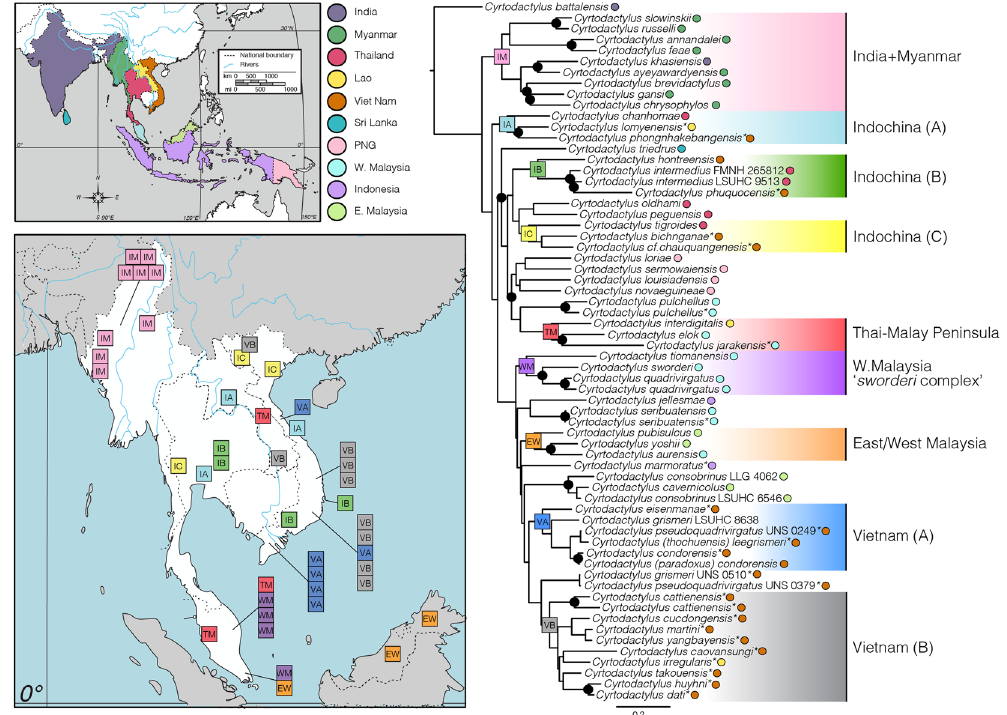
Figure 2. ‘Standardized ND2 ’ Maximum likelihood genealogy of ND2 including only taxa for which COI sequence data also exist. Circles at nodes indicate clade congruence between ND2 and COI loci, with BSS values of ≥ 70: blue indicate species groups, black interspecific sampling. Asterisks indicate new ND2 sequences contributed by this study. Upper map shows the geopolitical distribution of samples included in this phylogeny, and colored circles associated with tree tips correspond to this map. Lower map highlights the Indochinese region, and boxes represent generalized sampling localities of species groups (IM, IA, IB, IC, TM, WM, EW, VA, VB; denoted by blue circles at nodes). Sampled country localities indicated by colored circles at the tree tips highlight the interdigitated nature of geographic relationships within phylogenetic species groups. Maps drawn and adapted by IGB in Adobe Illustrator CS6 from public domain image provided by Wikimedia